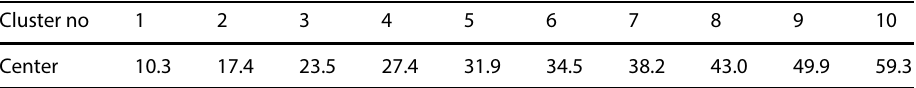
Table 7 Occurrence cluster centers obtained from k -means